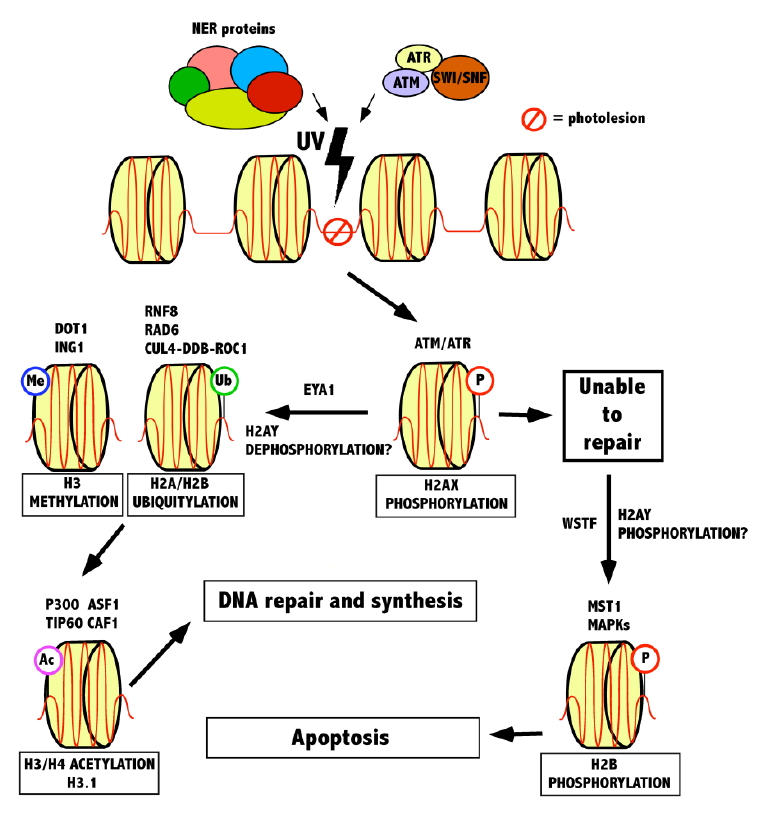
Figure 2. The involvement of histone modifications in cell decisions following UV damage. Chromatin consists of DNA wrapped around nucleosomes in higher order structures. UV damage causes damage to this DNA in the form of photolesions, influencing the recruitment of ATM/ATR, SWI/SNF and an arrangement of NER proteins. ATM/ATR is responsible for the phosphorylation of histone H2AX, serving as a binding site for various repair and checkpoint proteins. This is followed by H2A/H2B ubiquitylation and H3 methylation, as well as acetylation of H3 and H4 histones, leading to repair synthesis. However, if repair is not possible, histone H2B is phosphorylated, influencing